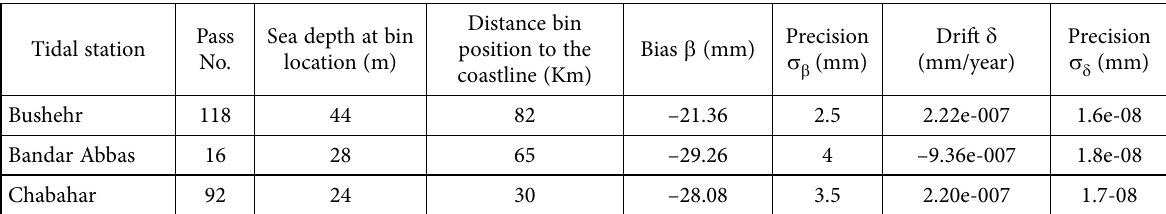
Table 3. Bias and drift of Topex/Poseidon estimated by the coastal tide gauge stations located at Bushehr, Bandar Abbas and Chabahar ports